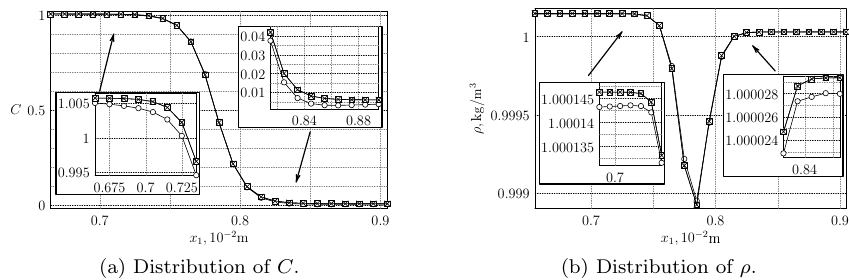
Figure 5. Problem 3.1: distributions of C and ρ for x 1 vicinity of interface for t = 4